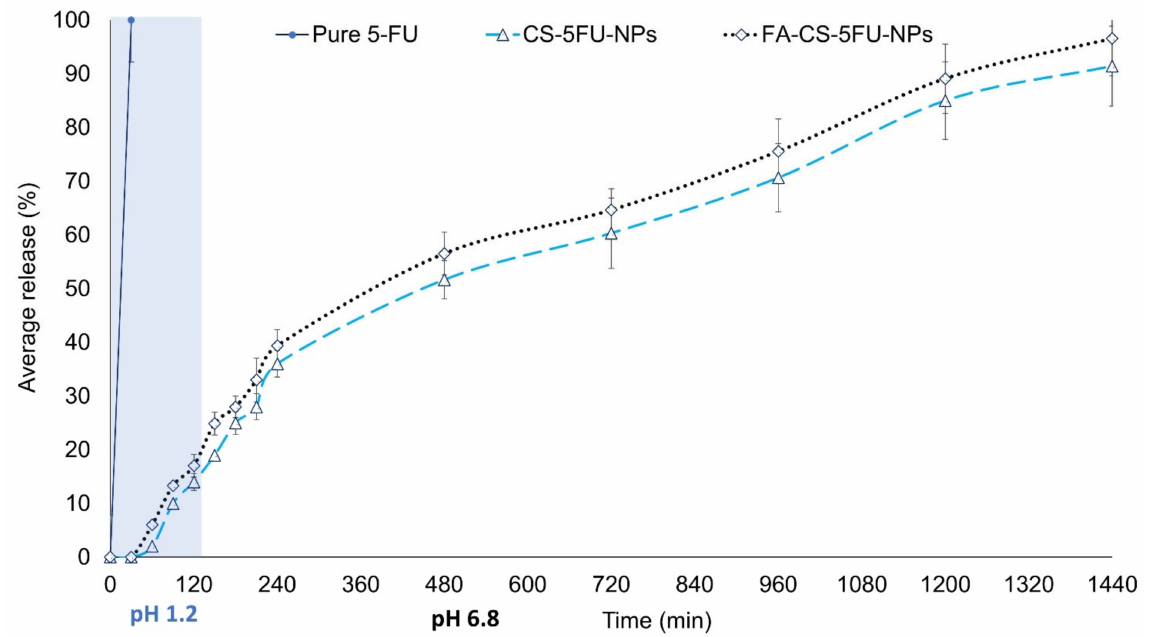
Figure 5. In vitro release study of pure 5-FU, CS-5FU-NPs, and FA-CS-5FU-NPs. Drug release at a pH of 6.5 within the first 2 h from the FA-CS-5FU-NPs and